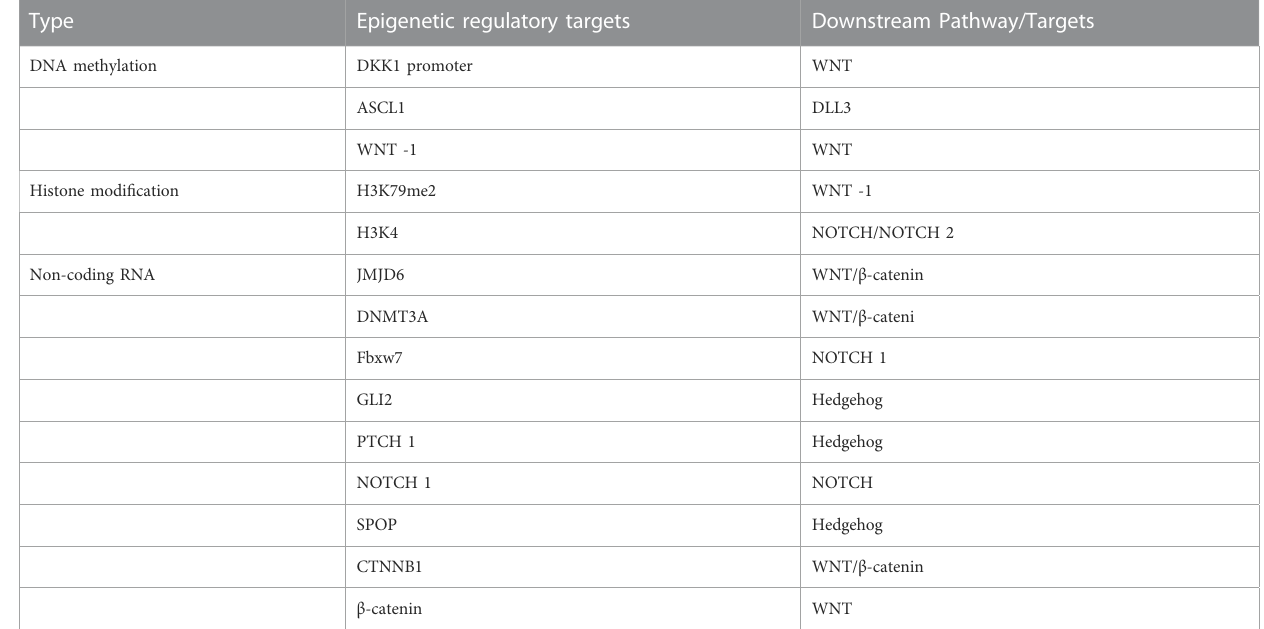
TABLE 1 Epigenetic targets acting on lung carcinogenesis and their downstream stem cell-related signaling pathways or targets.